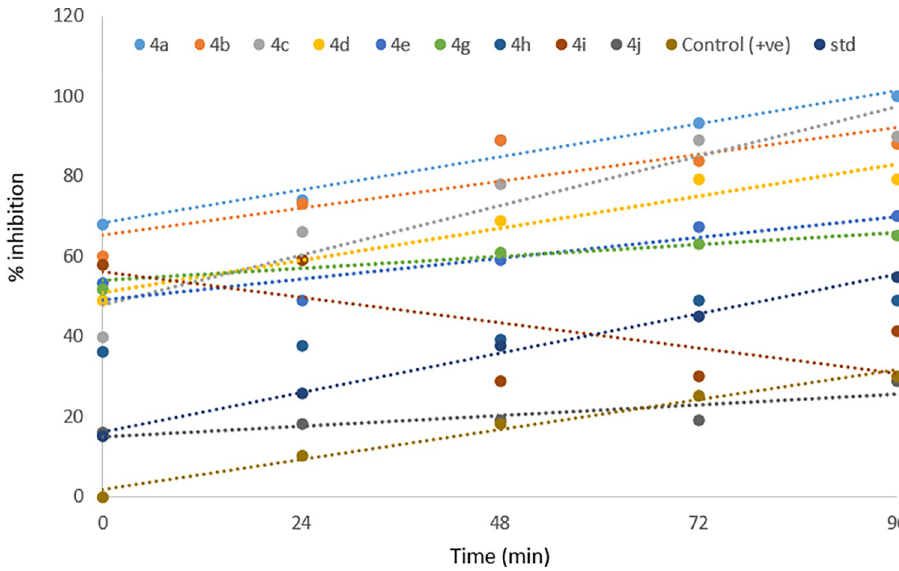
Fig 6. Determination of % inhibition of protease activity ( μ /mL)